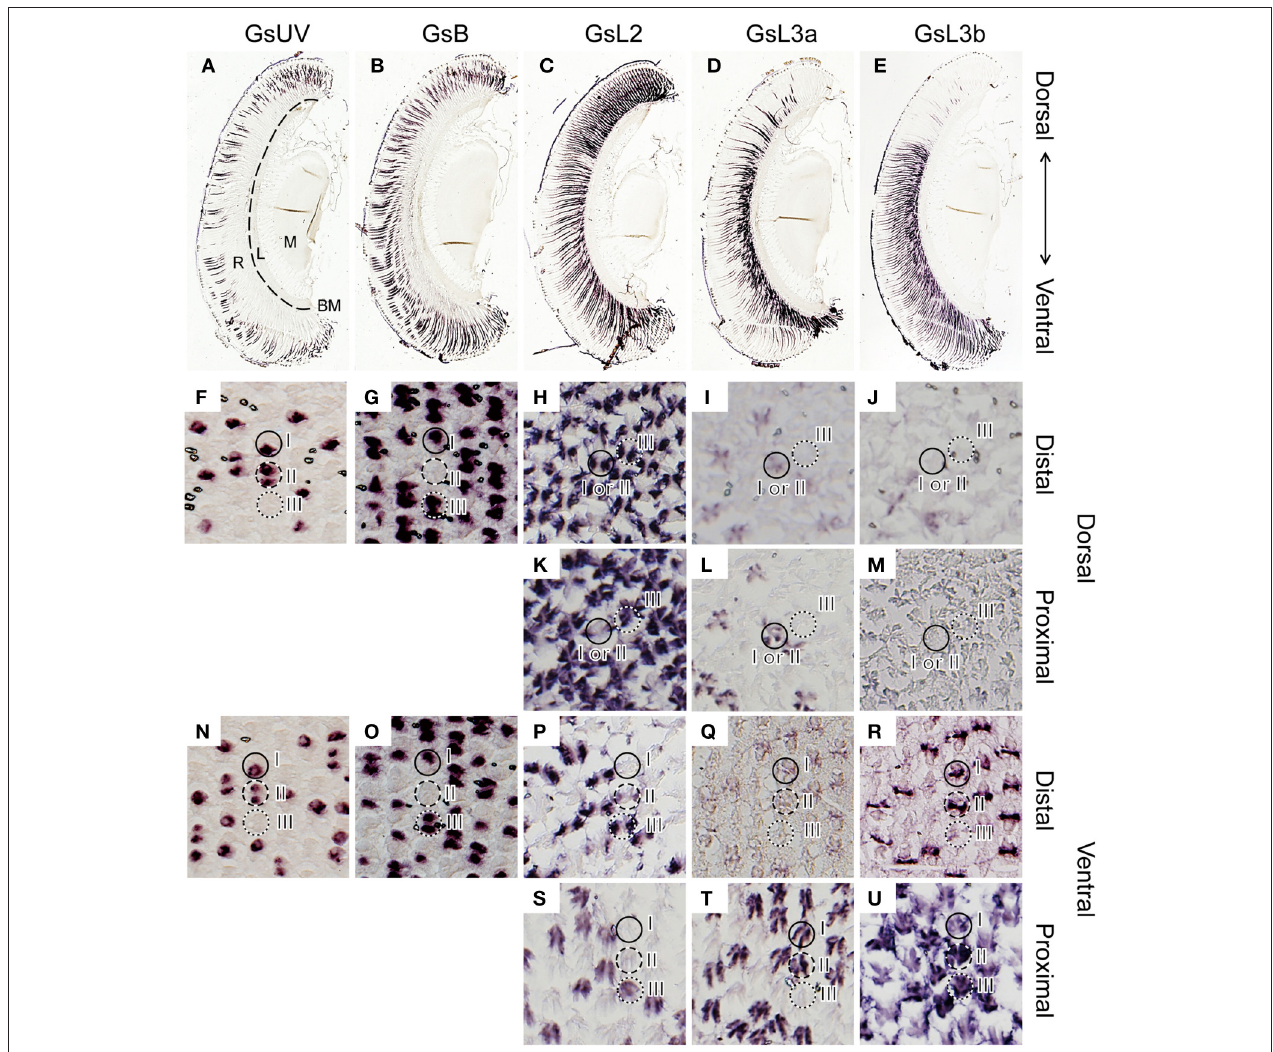
FIGURE 3 | In situ hybridization of five opsins of Graphium sarpedon (A–E, longitudinal sections; F–U, transverse sections). The sections were labeled with probes specific to the GsUV ( A , F , N ), GsB ( B , G , O ), GsL2 ( C , H , K , P , S ), GsL3a ( D , I , L , Q , T ), or GsL3b ( E , J , M , R , U ) mRNAs. Two sets of serial sections through the dorsal (F–M) and ventral regions (N–U) show the existence of three types of ommatidia in both regions. Ommatidial types are indicated by solid (type I), dotted (type II), and dashed circles (type III). R, retina; L, lamina; M, medulla; BM, basement